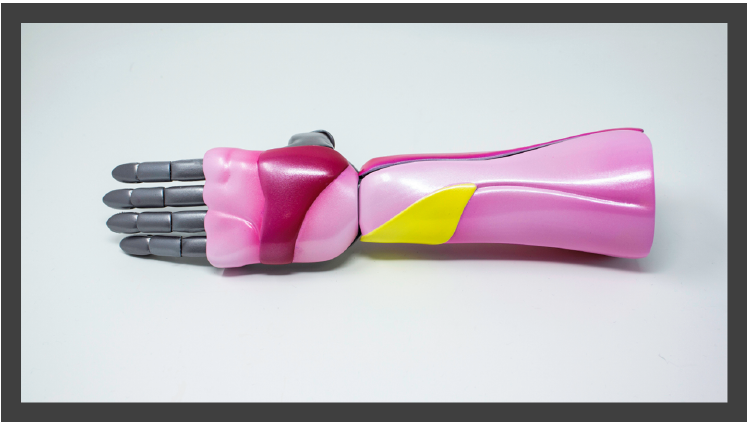
Figure 4. Completed aesthetic cosmesis components assembled on prosthesis for clinical